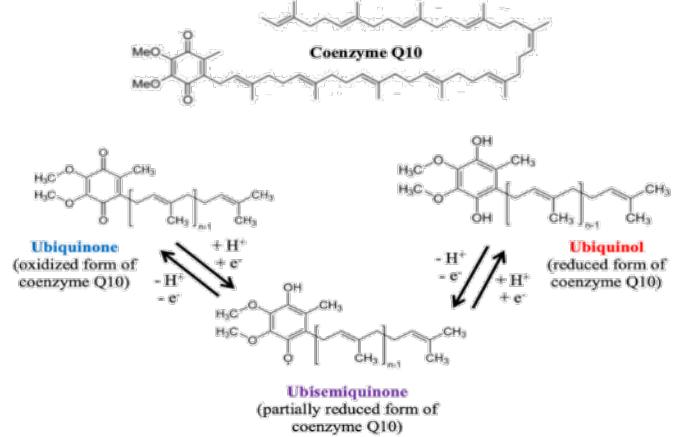
Figure 2. Chemical structure and transformations of coenzyme Q10.